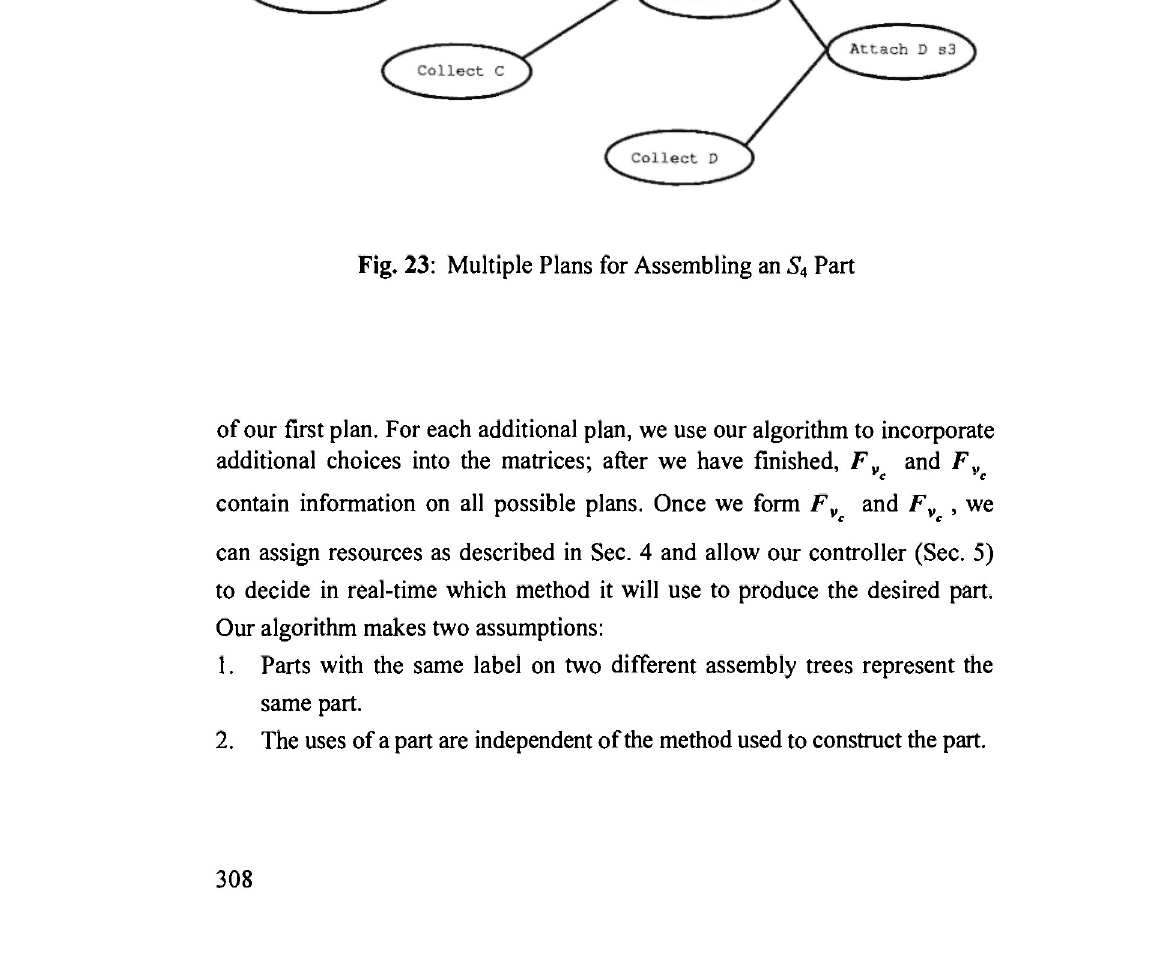
Fig. 23: Multiple Plans for Assembling an S 4